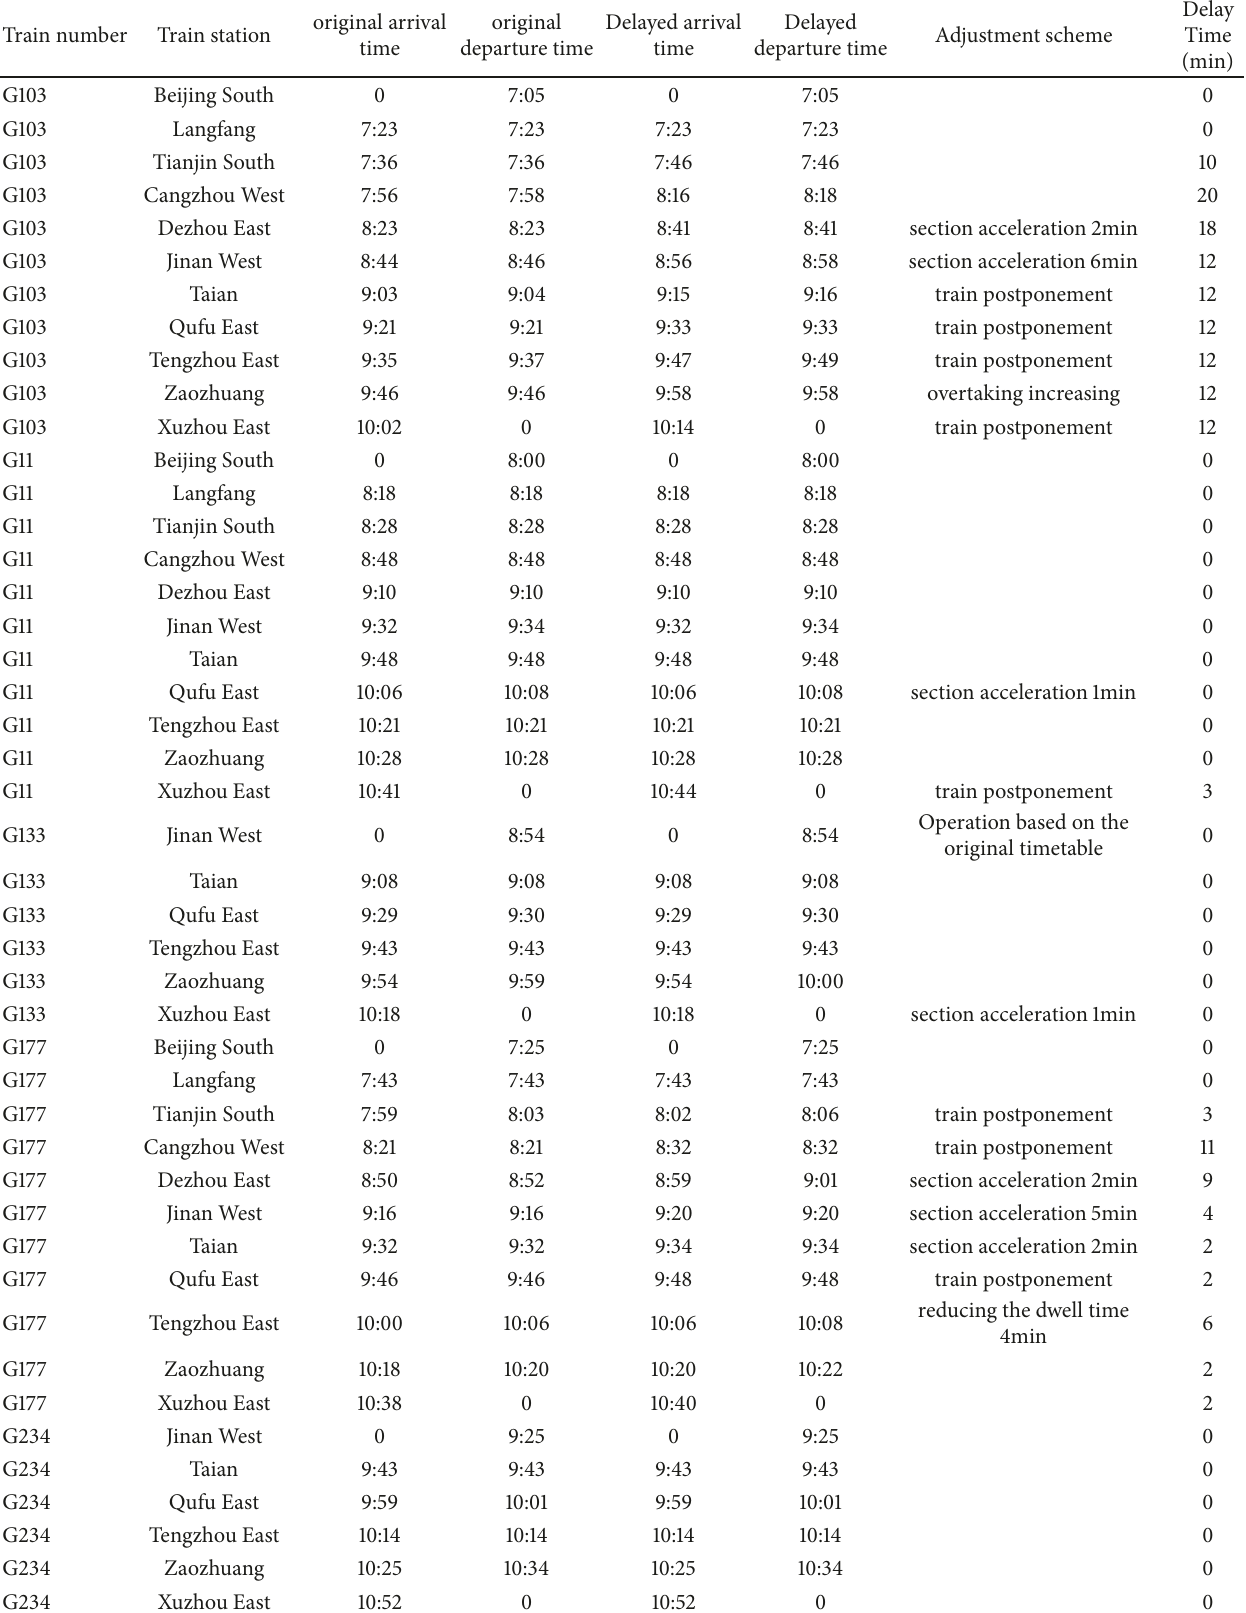
Table 2: The original timetable and adjusted